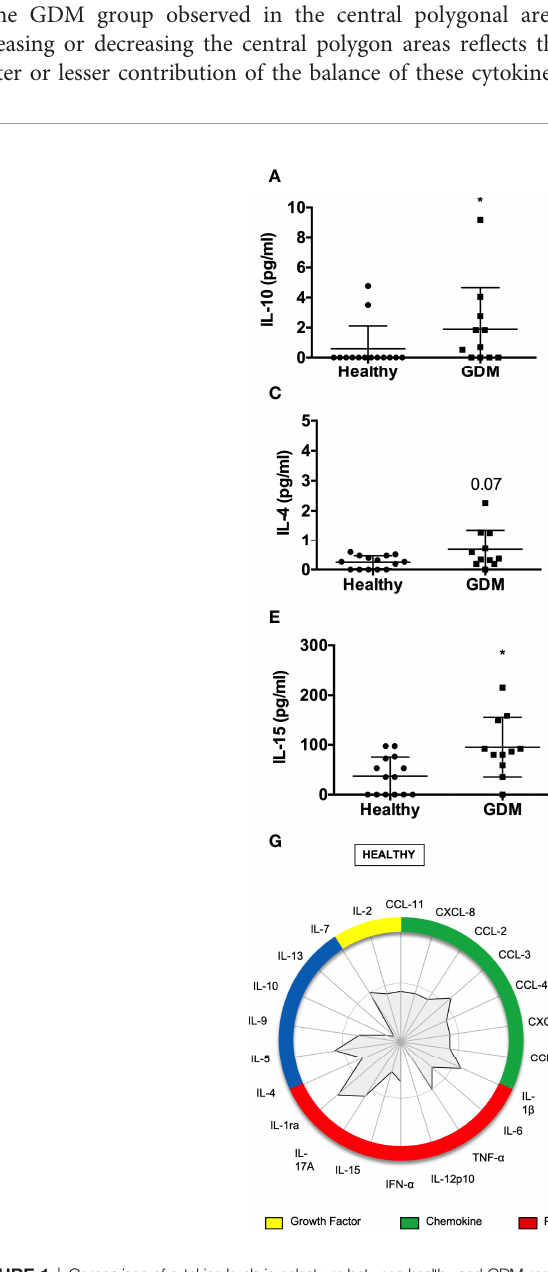
FIGURE 1 | Comparison of cytokine levels in colostrum between healthy and GDM mothers. The concentrations of cytokines and chemokines were measured in colostrum by Luminex. The circles represent women classi fi ed as having a usual gestational risk. The squares represent women with GDM. A total of 25 samples were included in the analyses. Each geometric fi gure represents a participant. (A) IL-10, (B) IL-1ra, (C) IL-4, (D) IFN- g , (E) IL-5, (F) IL-6. * p < 0.05. (G) Global pro fi le of cytokines/chemokines in colostrum of postpartum women, according to risk classi fi cation during pregnancy. The radar graph shows the frequency of high producers of pro-in fl ammatory, anti-in fl ammatory, and chemokines levels, and the contribution of each in the different categorizations (habitual risk and